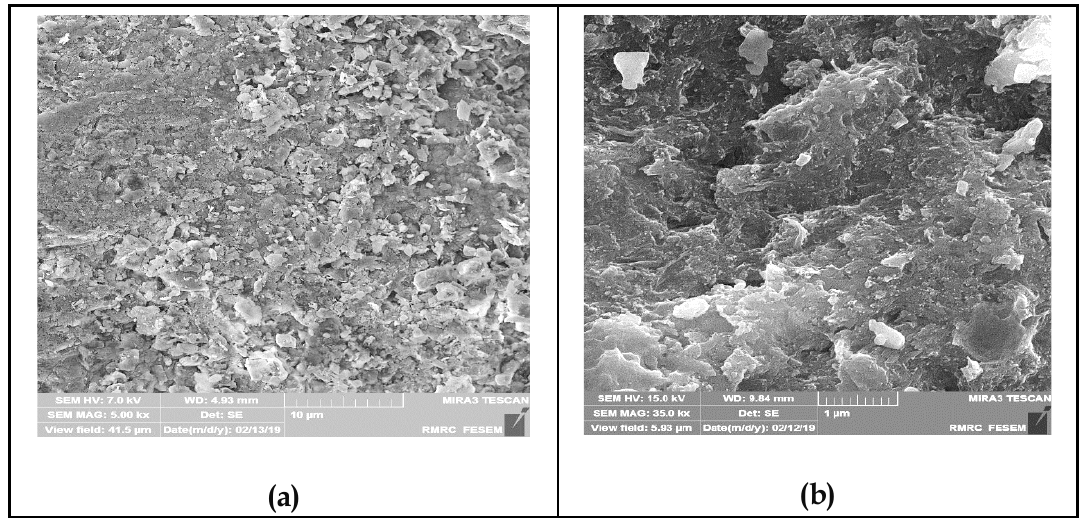
Figure 1. Electronic microscopic images of chitosan-activated carbon nanocomposite, before (a) and after (b) adsorption